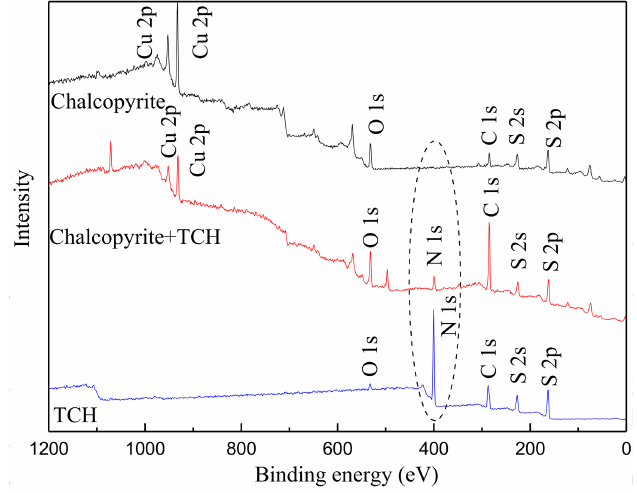
Figure 6. XPS spectra of TCH and chalcopyrite with and without